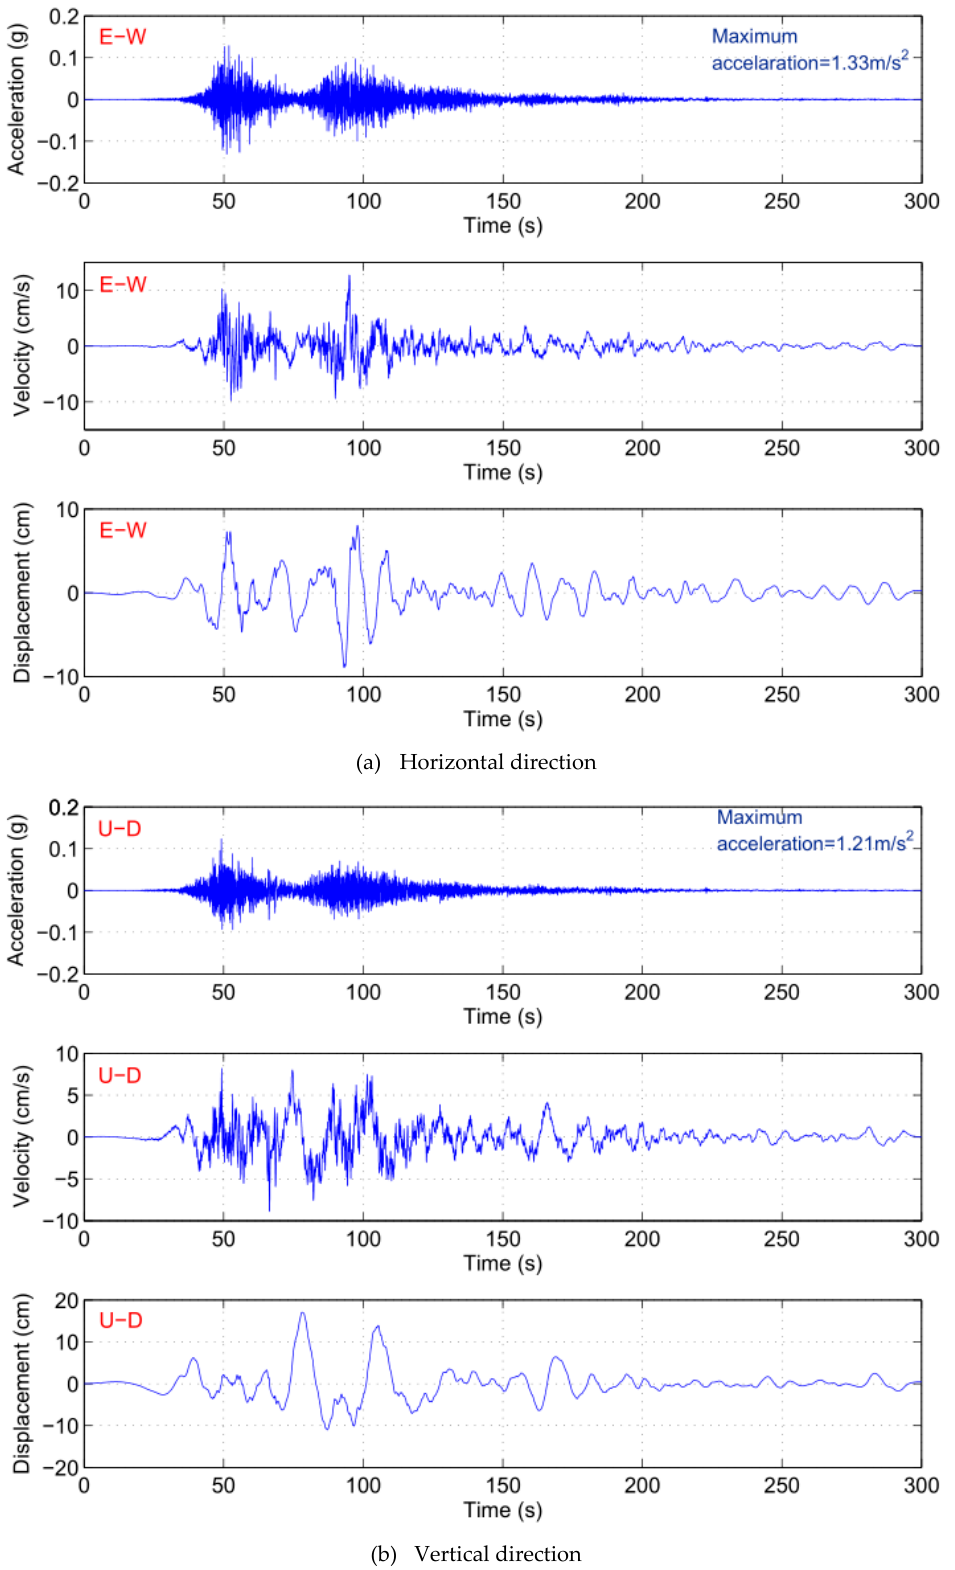
Figure 3. Input seismic wave after wave filtering adopting the recorded seismic wave at the station MYGH03 (141.6412E, 38.9178N, buried depth = 120 m) at Karakuwa, Japan during 311 off-Pacific earthquake event. Noted: Noncausal butterworth filter is used; filtering range: f ≤ 0.03Hz and f ≥ 30 Hz.